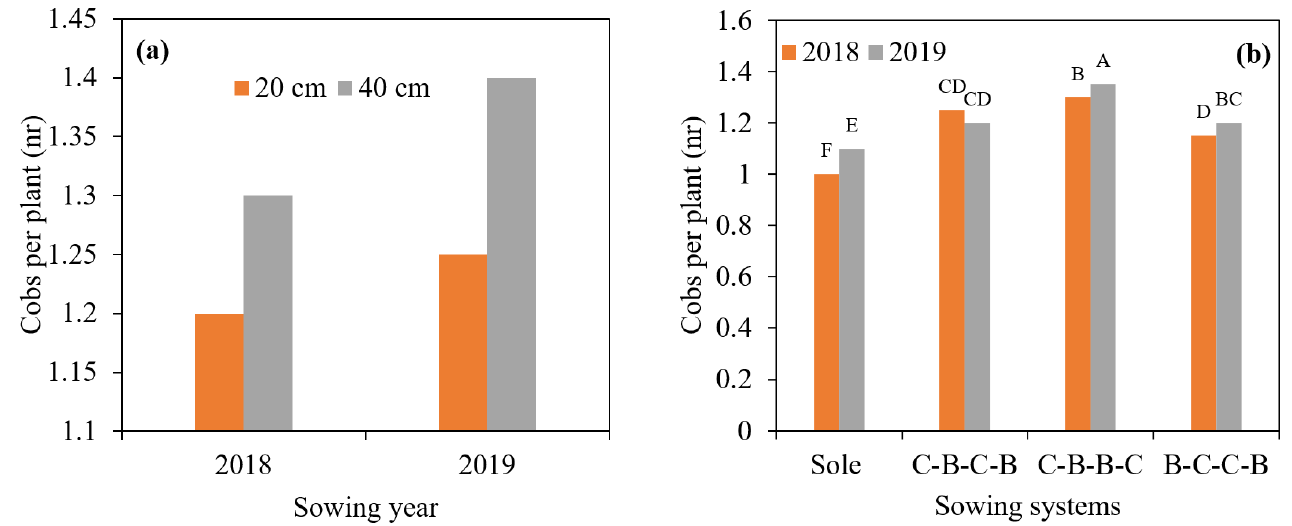
Figure 1. The interactions of maize–white bean sowing systems using cobs per plant for the year x row spacing interaction ( a ) and the year x sowing system interaction ( b ) at the study location in Nur Sultan, Kazakhstan. Letters on each bar represent a significance level at p < 0.01. Note: different letters denote significant differences, while the same letters indicate insignificantly different values.